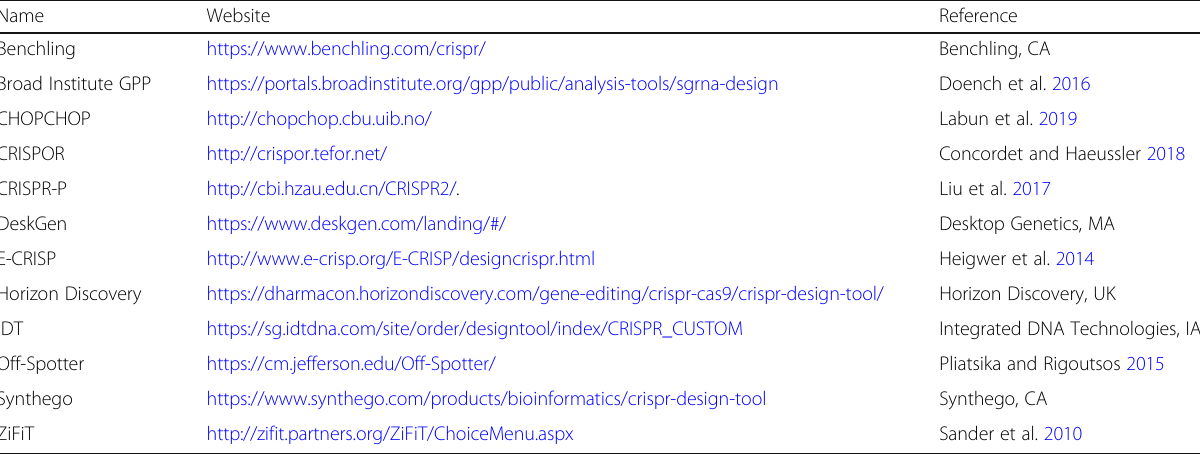
Table 1 Web-based tools for sgRNA design